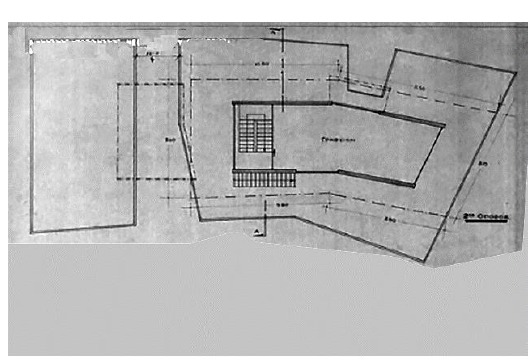
Figure 9. second-floor